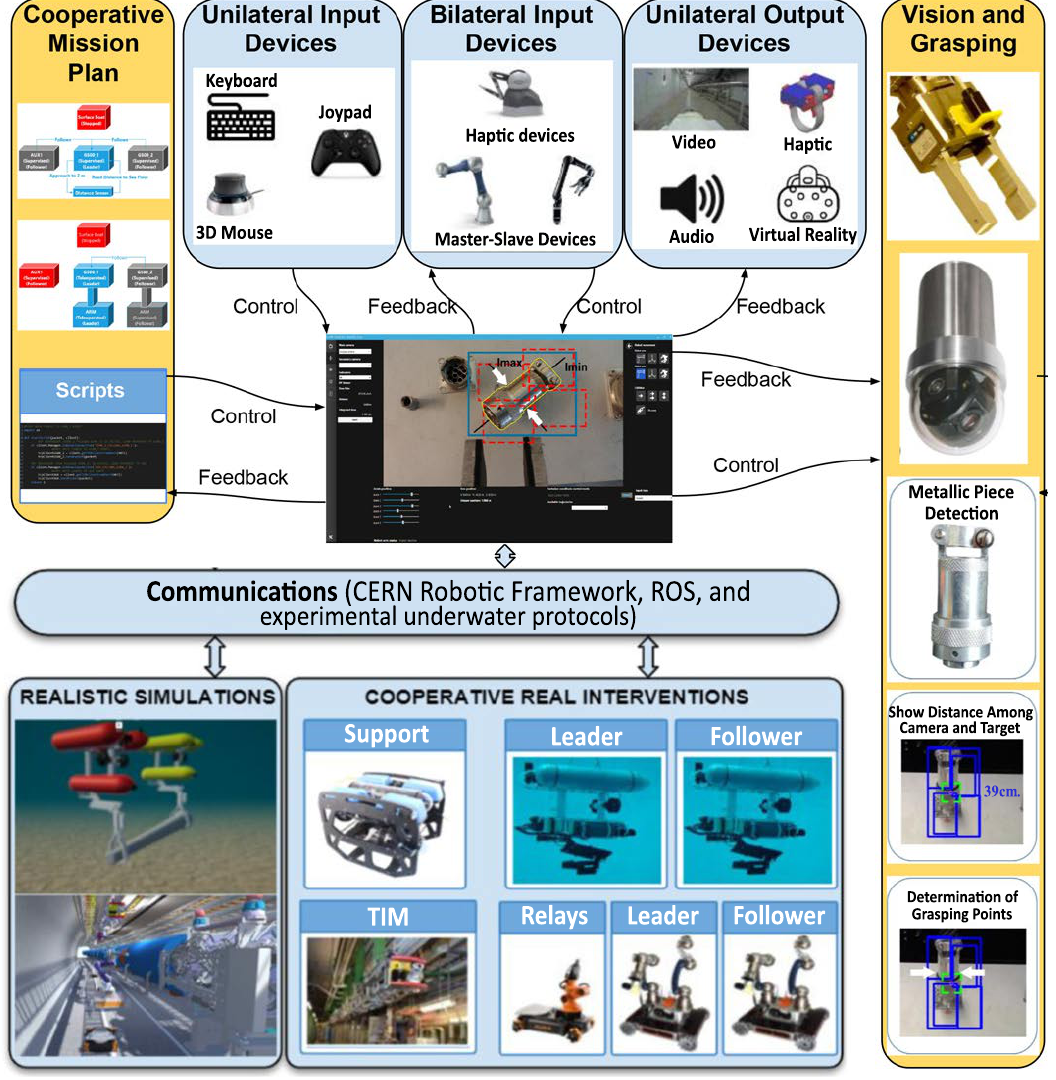
Figure 9. User interface